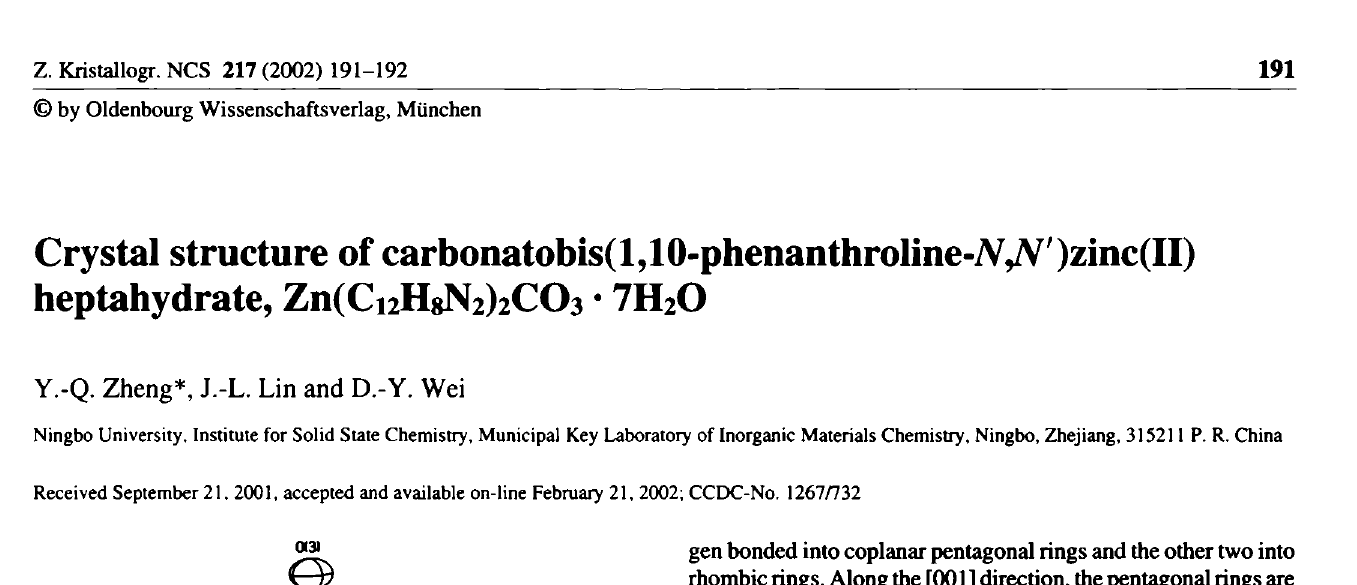
Table 1. Data collection and handling.